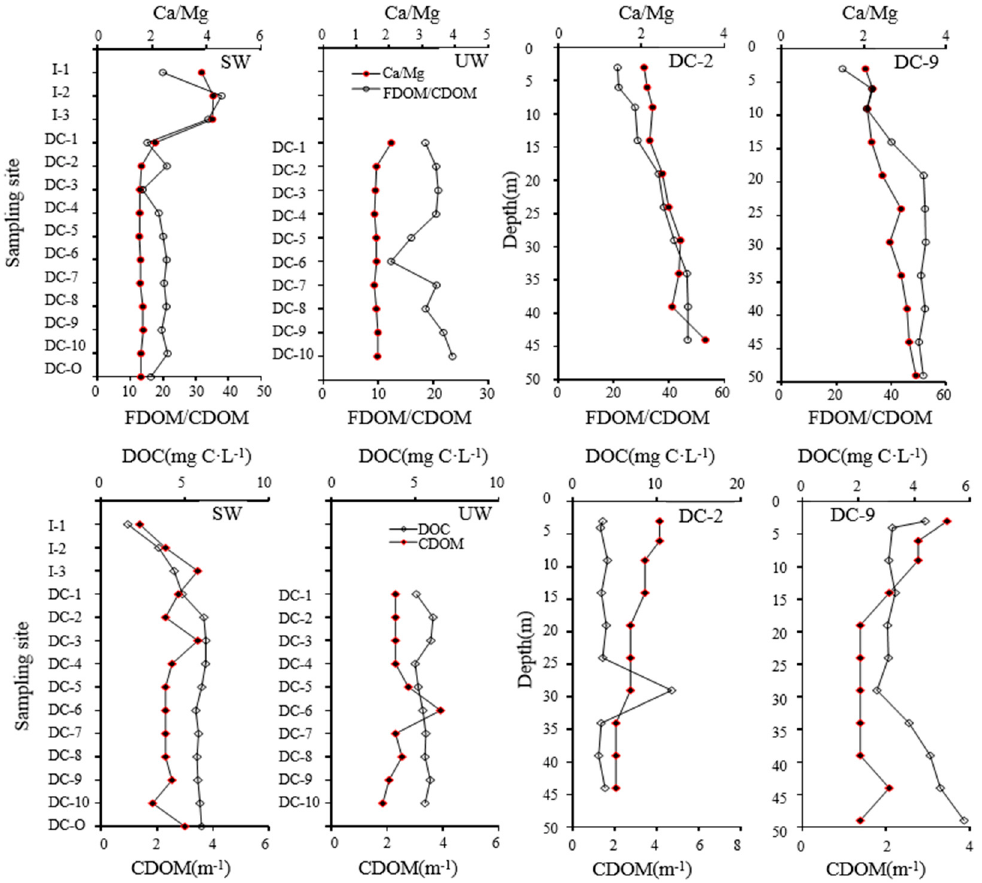
Figure 4. The variation trends of Ca/Mg and organic component (FDOM/CDOM) ratios in horizontal and vertical watercourses in Dianchi Lake. SW: surface water; UW: underlying water. For the sampling sites (I-1, I-2, I3, and DC1-10), see Figure 1. DOC: dissolved organic carbon; FDOM: fluorescent dissolved organic matter; CDOM: colored dissolved organic matter.